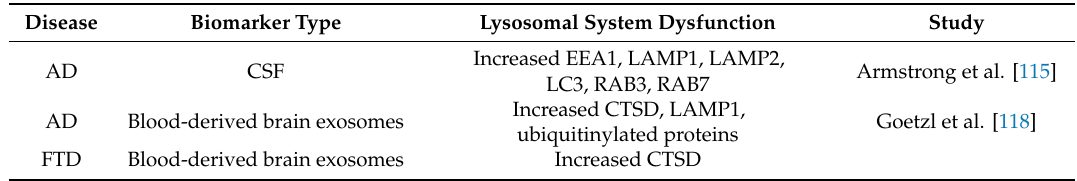
Table 1. Altered lysosomal markers in neurodegenerative